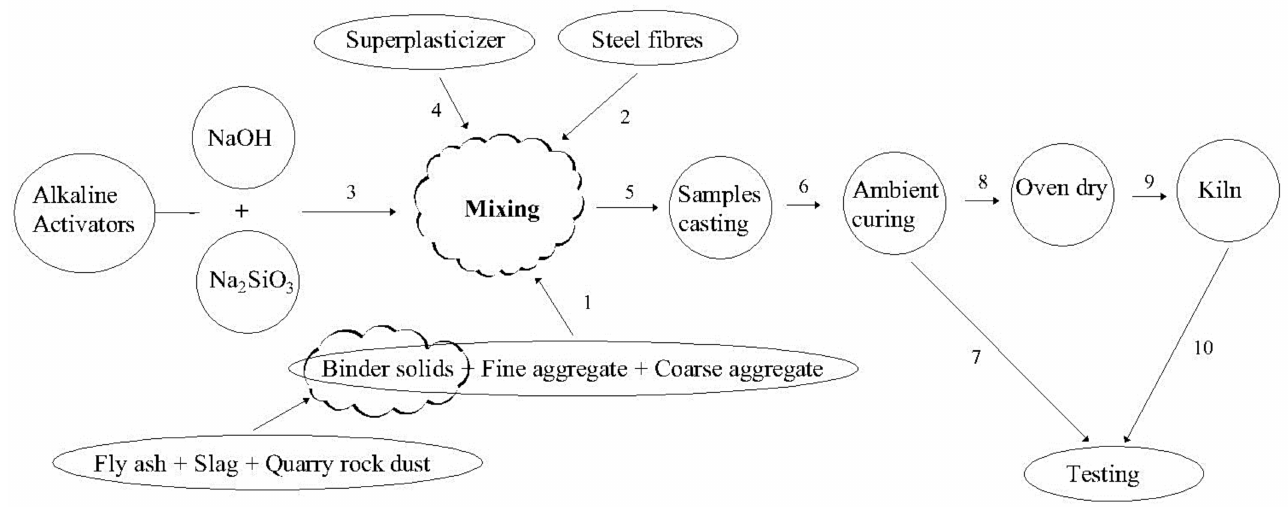
Figure 3. The mix production to the testing sequence of GPC specimens. 1—mixing of Raw materials; 2—adding Steel fibers; 3—Adding alkaline solution; 4—Adding superplasticizer; 5—Casting of samples; 6—Curing of samples at room temperature; 7—Compressive, tensile and flexural testing of samples; 8—Oven dry of samples; 9—Heating of samples at elevated temperature; 10—Mechanical